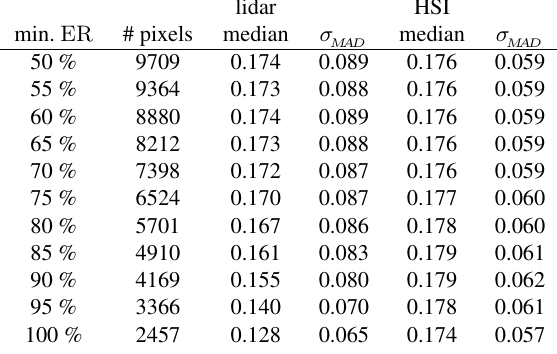
Table 2: Reflectance distribution in test area 4 w.r.t. to a minimum echo ratio ( ER ). See also Figure